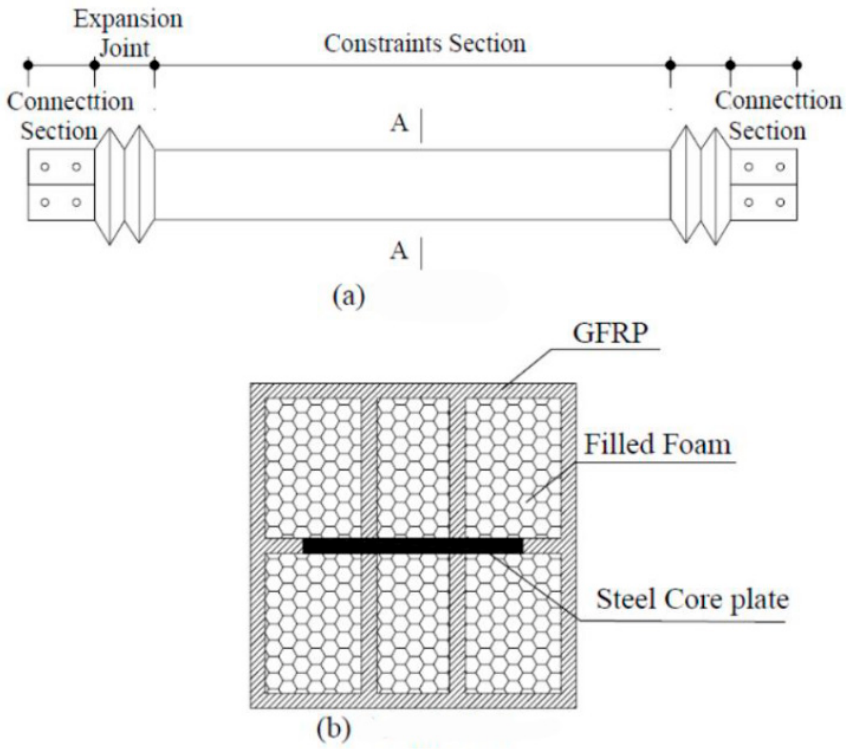
Figure 1. Configuration of the specimen. ( a ) Plan view; ( b ) Section